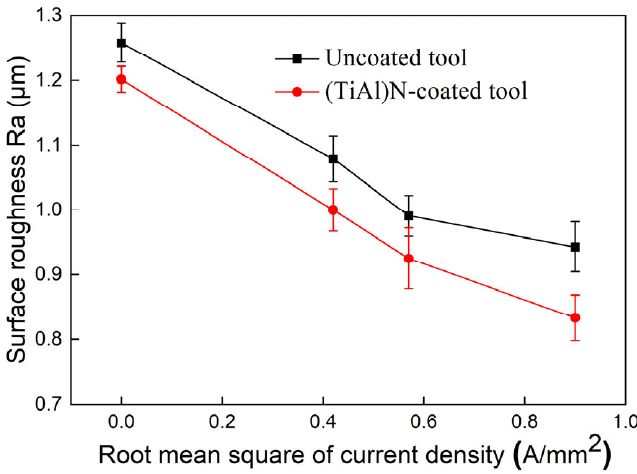
Figure 5. Change in the surface roughness Ra with the increase in current density.